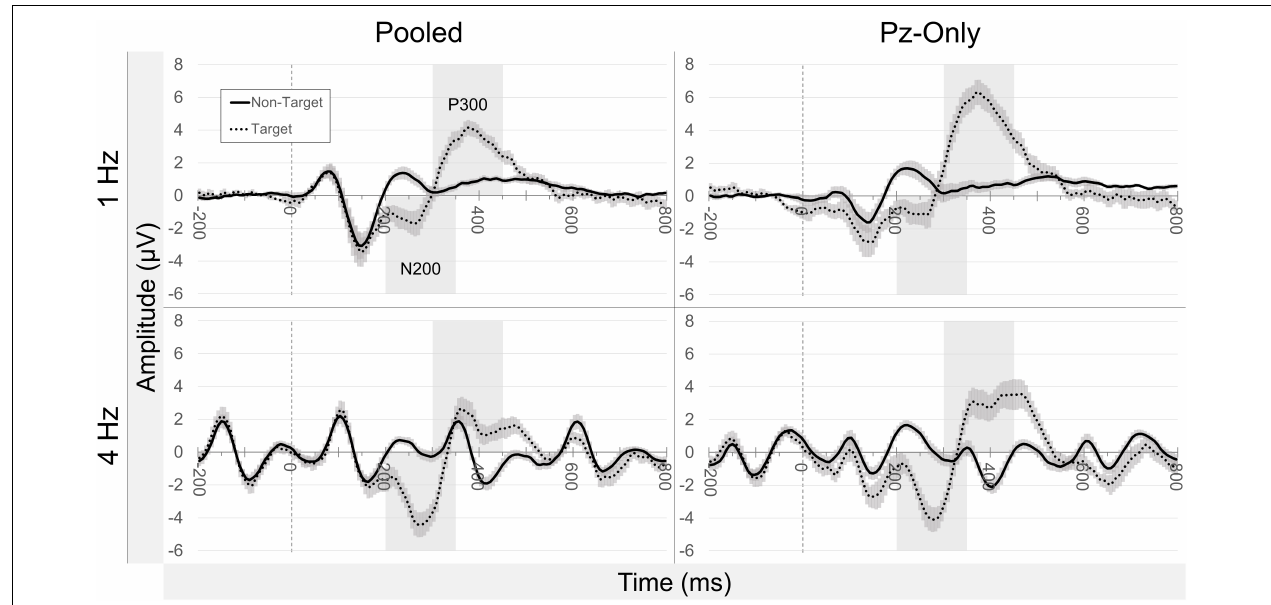
FIGURE 6 | Grand average ERP waveforms. Grand average ERP waveforms averaged across all participants ( ± SEM), relative to stimulus onset ( t = 0). Plots are separated by condition (presentation rate; stimulus class) and electrode source (pooled occipitoparietal sites; Pz-only). Highlighted temporal regions illustrate default window settings of peak detection for the N200 and P300